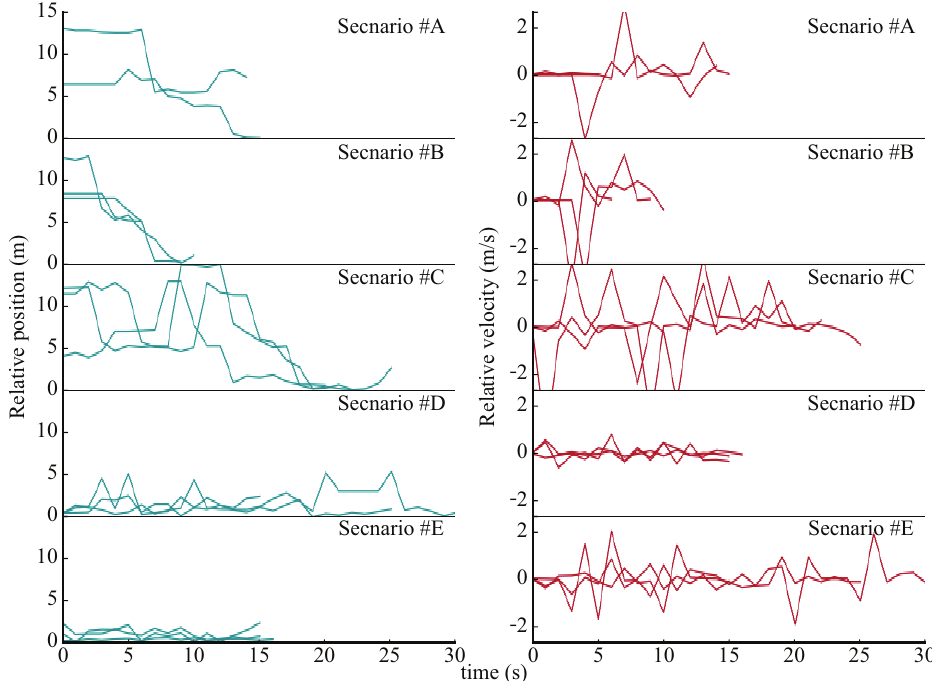
Figure 9. Behavior of the tracked relative relationships among multiple IR Beacons.